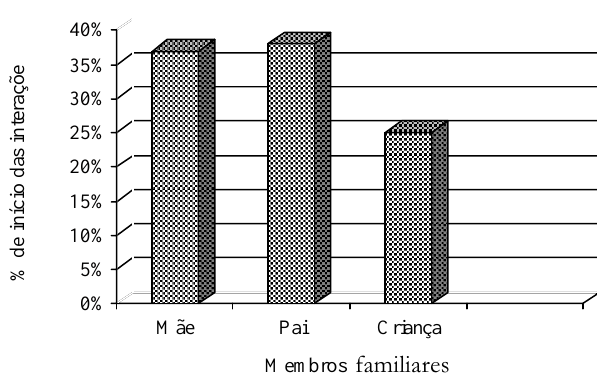
Figura 2. Responsabilidade pelo in(cid:237)cio de intera(cid:231)ıes.